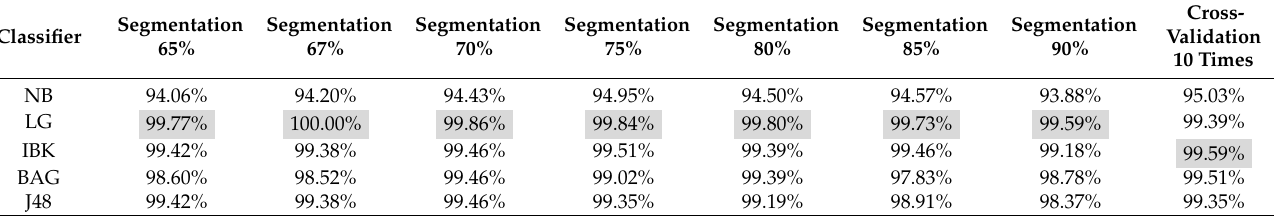
Table 12. The classifier accuracy of feature selection for 1964 normal and 491 bankrupt companies (4:1). Classifier